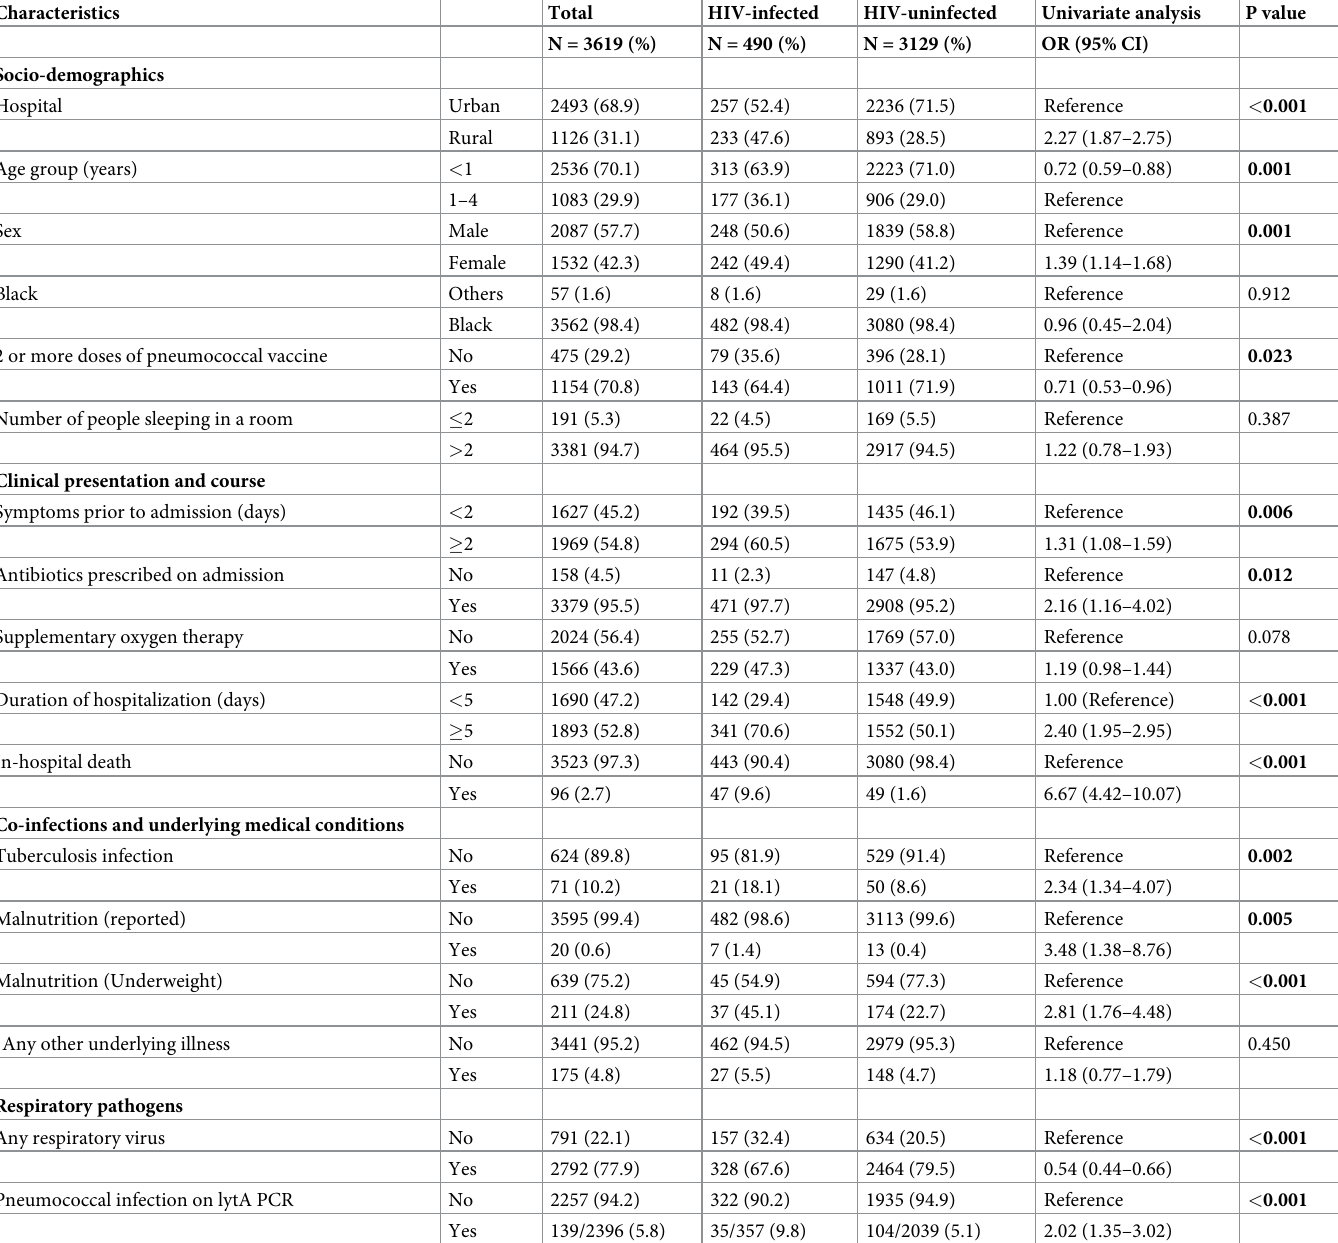
Table 2. Demographics and clinical characteristics of HIV-infected and HIV-uninfected children aged < 5 years hospitalized with SARI at urban and rural hospi- tals, South Africa 2009–2013.